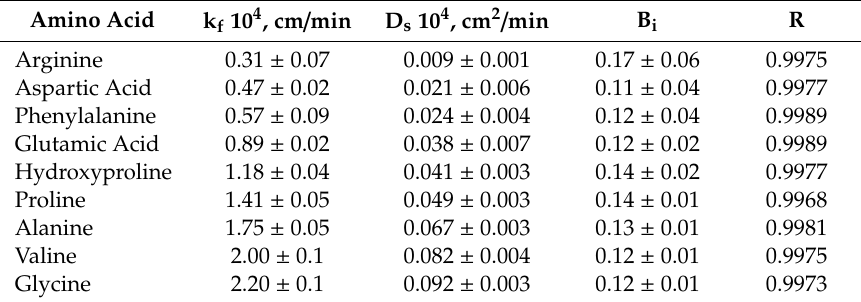
Table 2. Parameters obtained by non-linear least-squares adjustment of Equation